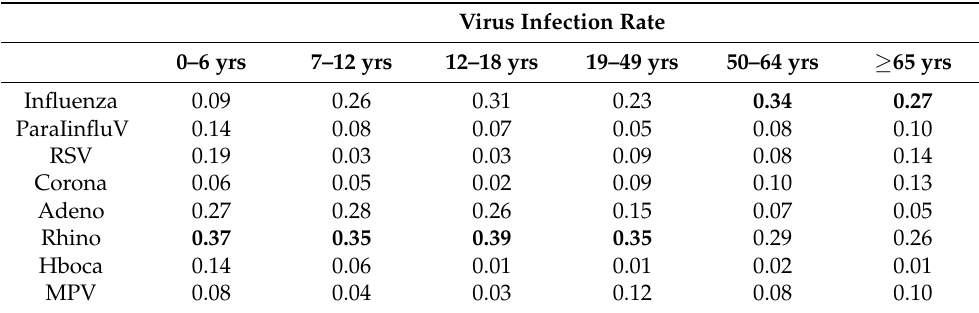
Table 2. Distribution of different types of viral infection rates detected in adult and pediatric patients, according to